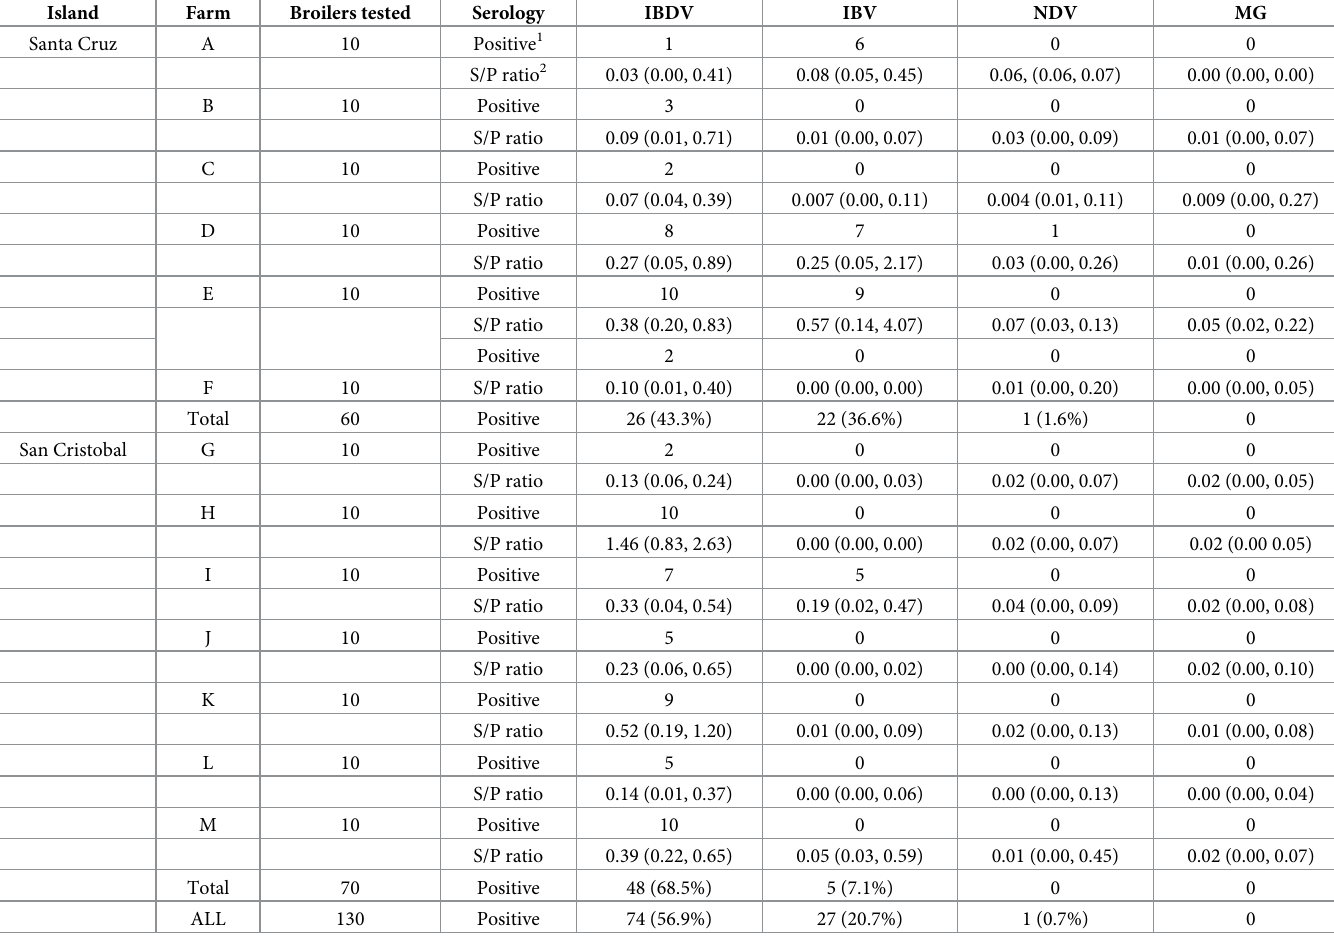
Table 2. Frequency of study broilers that tested positive to antibodies against infectious bursal disease virus (IBDV), infectious bronchitis virus (IBV), Newcastle disease virus (NDV), or M. gallisepticum (MG) on 13 study broiler farms.